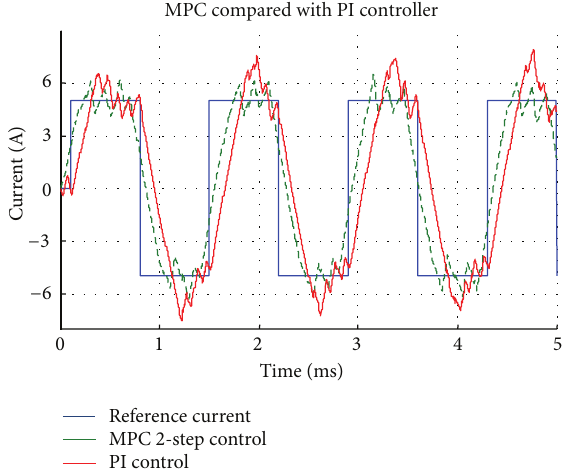
Figure 17: Step test: current tracking obtained using MPC (2-step prediction) and PI controller.